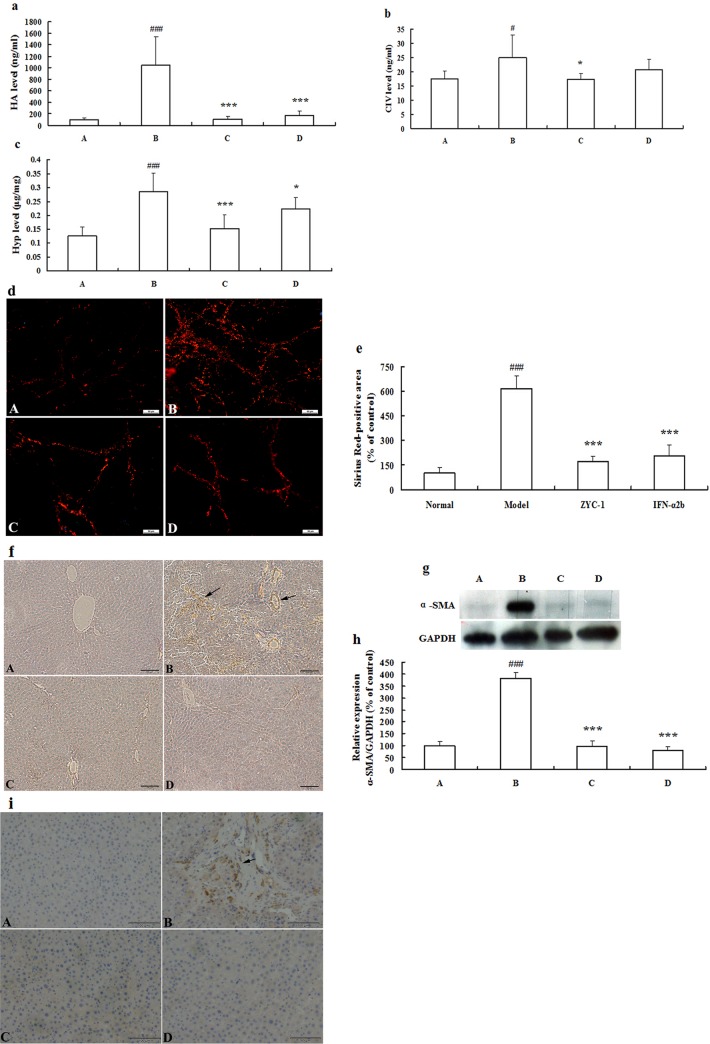
Effects of ZYC-1 on DMN-induced rat liver fibrosis: the levels of (a) HA, (b) CIV, and (c) Hyp in the serum of rats. (d) Staining with Sirius Red Bar = 50 μm. (e) Quantitative levels were evaluated by the mean of polarized light intensity using Image Pro Plus 6.0 software in (d). (f) α-SMA expression in liver tissue was analyzed by immunohistochemistry Bar = 100 μm. (g) Protein expression of α-SMA was detected by Western blot, and the gels have been run under the same experimental conditions. Cropped blots are used in (g), and full-length blots are presented in supporting information (S3 Fig). (h) Densitometry analysis is presented as the relative ratio of protein (α-SMA)/GAPDH using Quantity One software (n = 3). (i) TGF-β1 expression in liver tissues was analyzed by immunohistochemistry Bar = 100 μm. (j) Quantitative levels were evaluated by the mean of positive area using Image J software in (i). The data represent the mean ± SD. A: normal group; B: DMN model group; C: ZYC-1 group; D: IFN-α2b group. #P < 0.05, ###P < 0.001 vs. normal group, *P < 0.05, ***P < 0.001 vs. DMN model group.